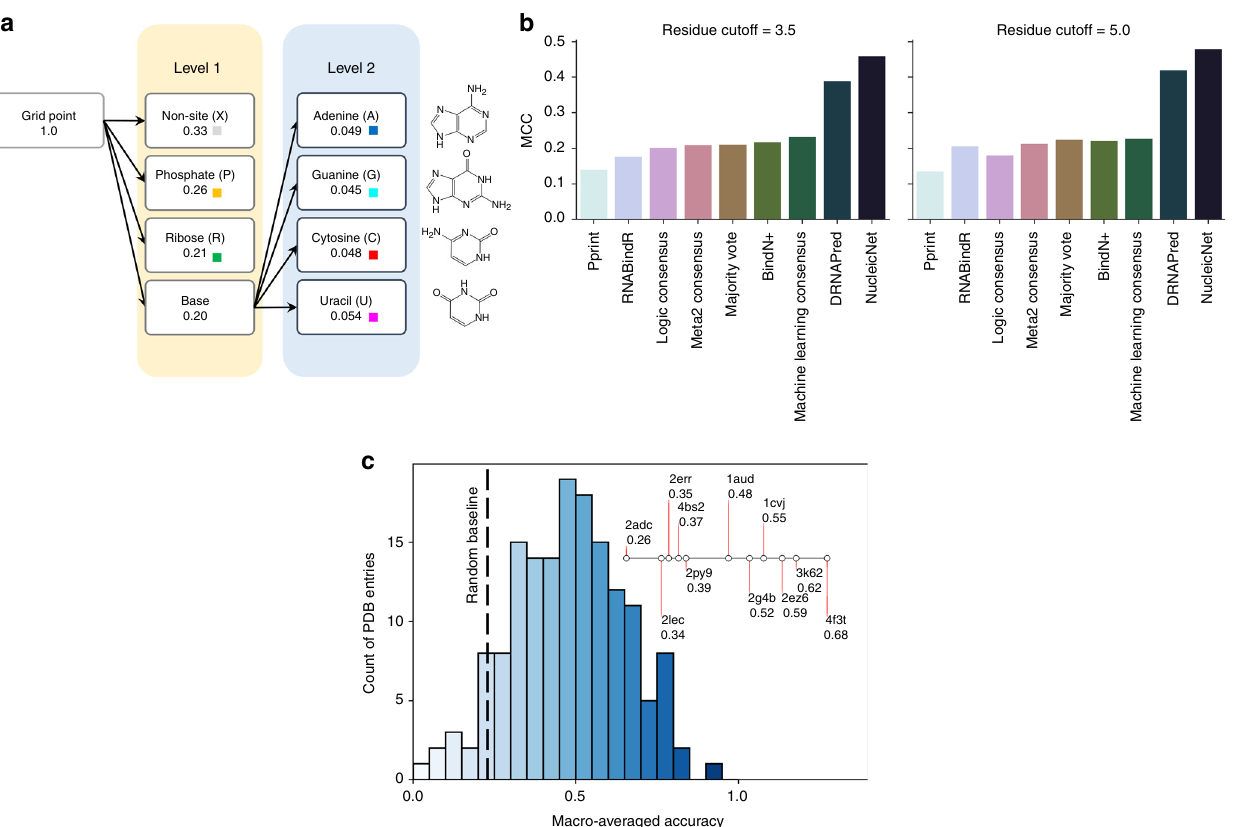
Fig. 2 Data statistics and performance of NucleicNet. a Statistics and hierarchy of a 7-class classi fi cation. Ratio of data available for each class is shown in the second line of each box. Each grid point is fi rst classi fi ed under 4 coarse labels – non-site, phosphate, ribose, and base – and then 4 fi ne base labels – Adenine(A)/Guanine(G)/Cytosine(C)/Uracil(U). Color code of each constituent is shown in as a square. b Benchmark of NucleicNet to distinguish sites from non-sites. All methods 13 – 16 listed from the recent review paper 11 were compared using Matthew ’ s Correlation Coef fi cient (MCC) in terms of the two cutoffs, in angstrom, as indicated in title. c Benchmark of NucleicNet to distinguish among the six RNA constituents and non-sites in 3-fold cross validation of the protein-RNA complex structures in PDB. A histogram of macro-averaged accuracy is provided. Baseline accuracy (0.23) referring to a random 7- class predictor is indicated with the dash